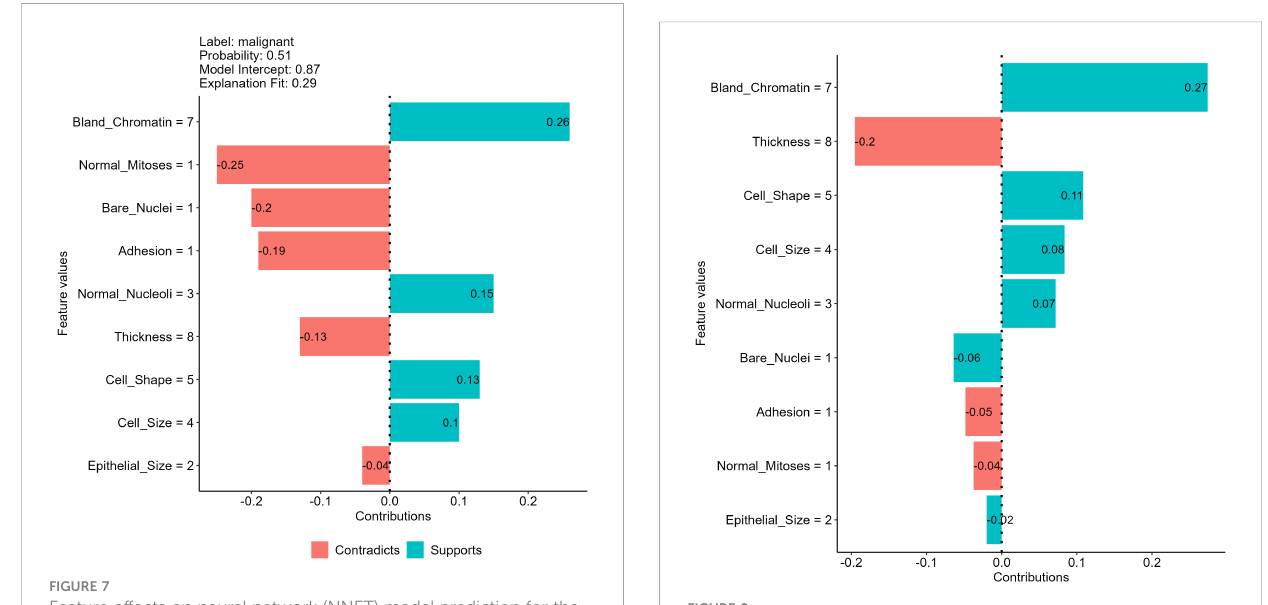
FIGURE 8 Insights into feature effects on model predictions from the Shapley additive explanation (SHAP)